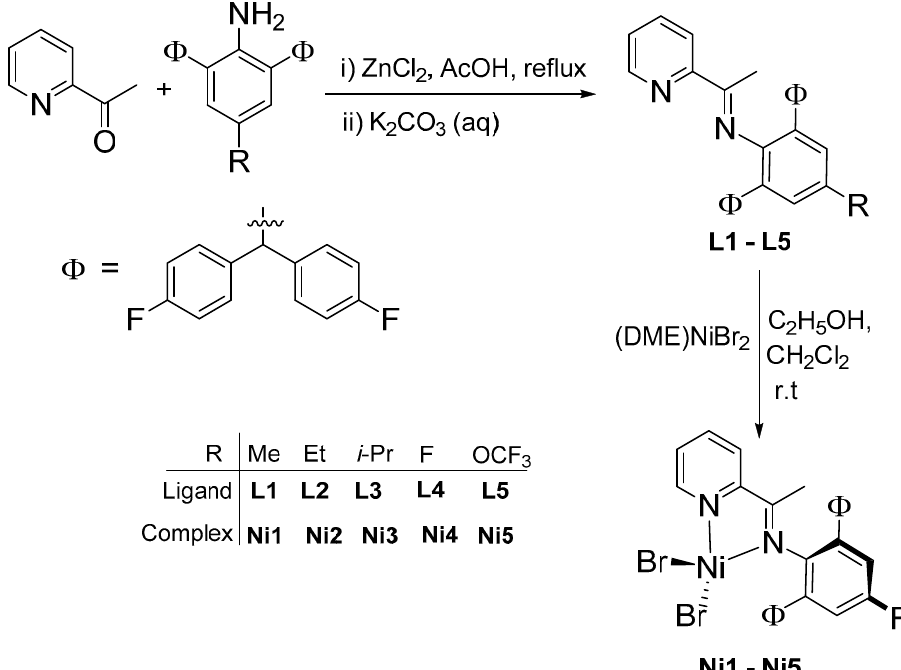
Scheme 1. Synthetic route to 2-(arylimino)pyridines, L1 – L5 and their corresponding nickel(II) bro- mide complexes, Ni1 – Ni5